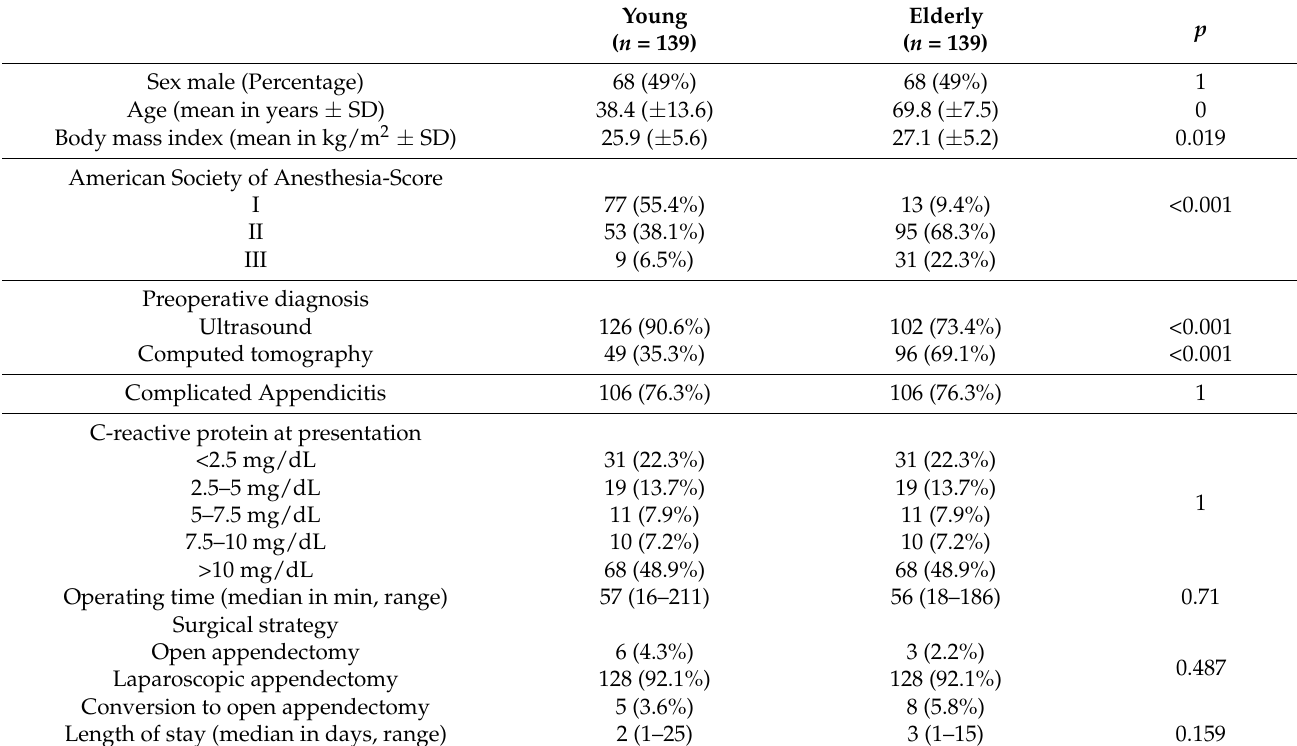
Table 1. Baseline